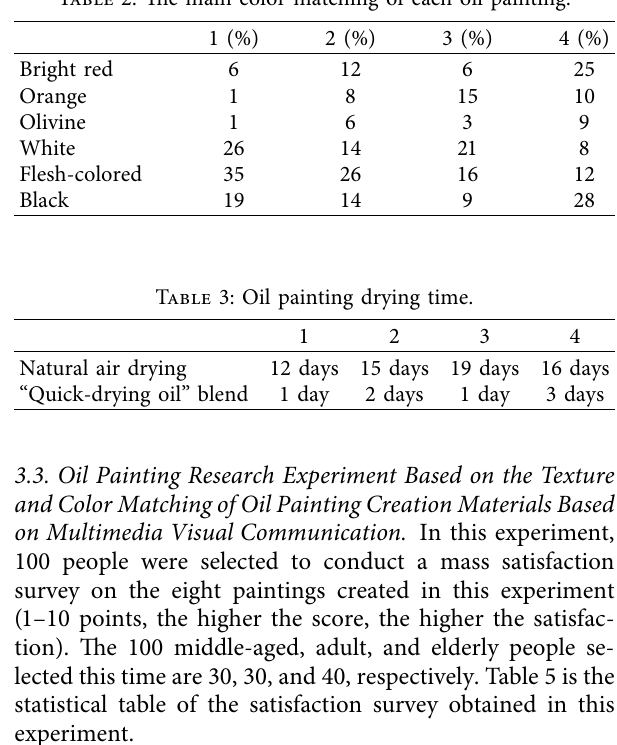
Table 2: The main color matching of each oil painting.